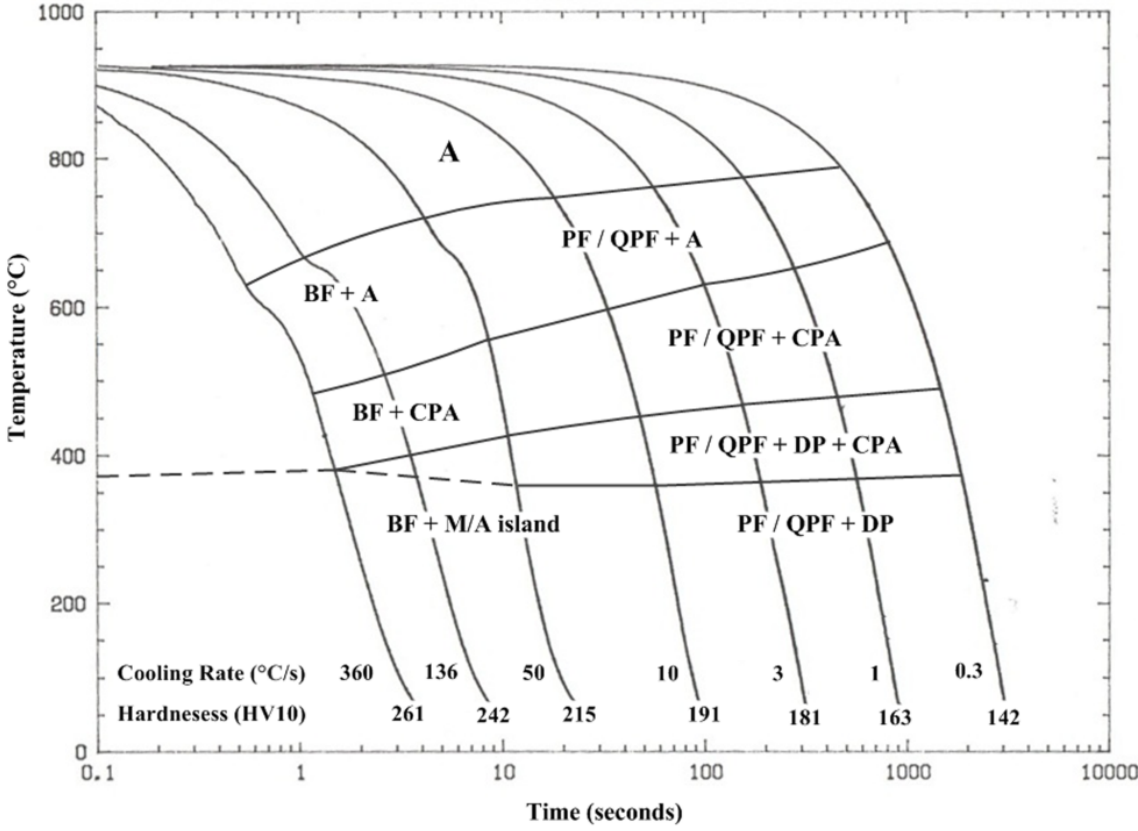
Figure 7: CCT diagram of API 5L X-60 pipeline steel for conditions of weld simulation. Pearlite, polygonal ferrite, quasi-polygonal ferrite, carbon partitioned austenite, plate-like bainitic ferrite and martensite/austenite island microconstituents are marked with P, PF, QPF, CPA, BF and M/A islands symbols,